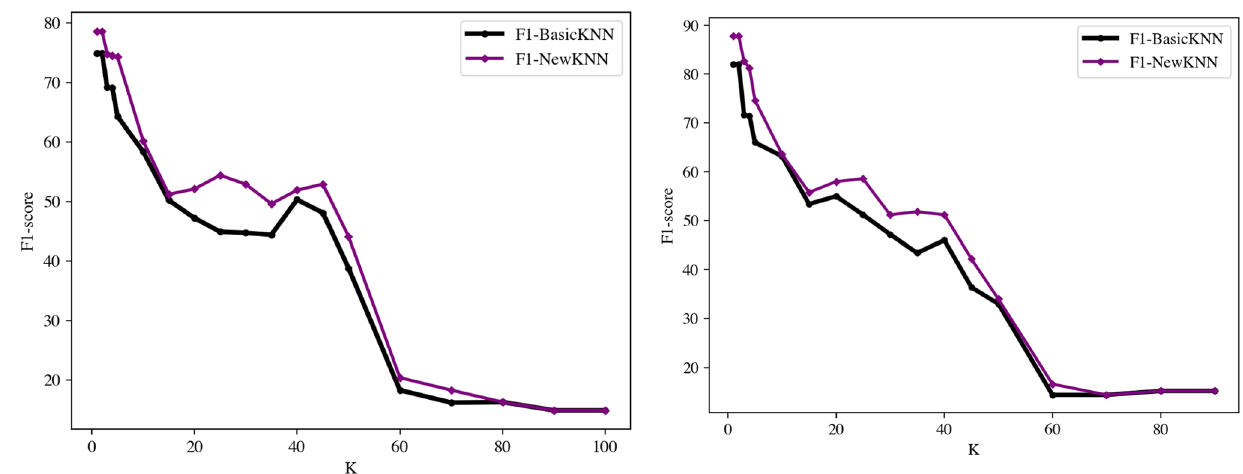
Fig. 6 F1-score evolution for KNN using Cosine distance with tenfold and fivefold cross-validation on Restaurant